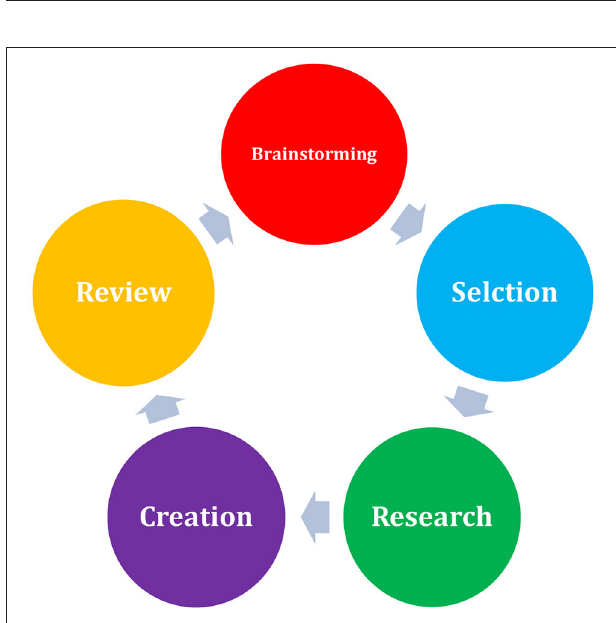
FIGURE 5 | CIPP before, during, and after installation. https://www.prweb. com/releases/uspipeliningpressrelease/june2016/prweb13466103.htm.